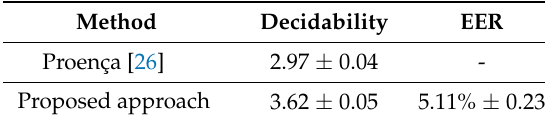
Table 1. Comparison of Proença [26] and our approach in the FRGC dataset ran 30 times. The mean and standard deviation are